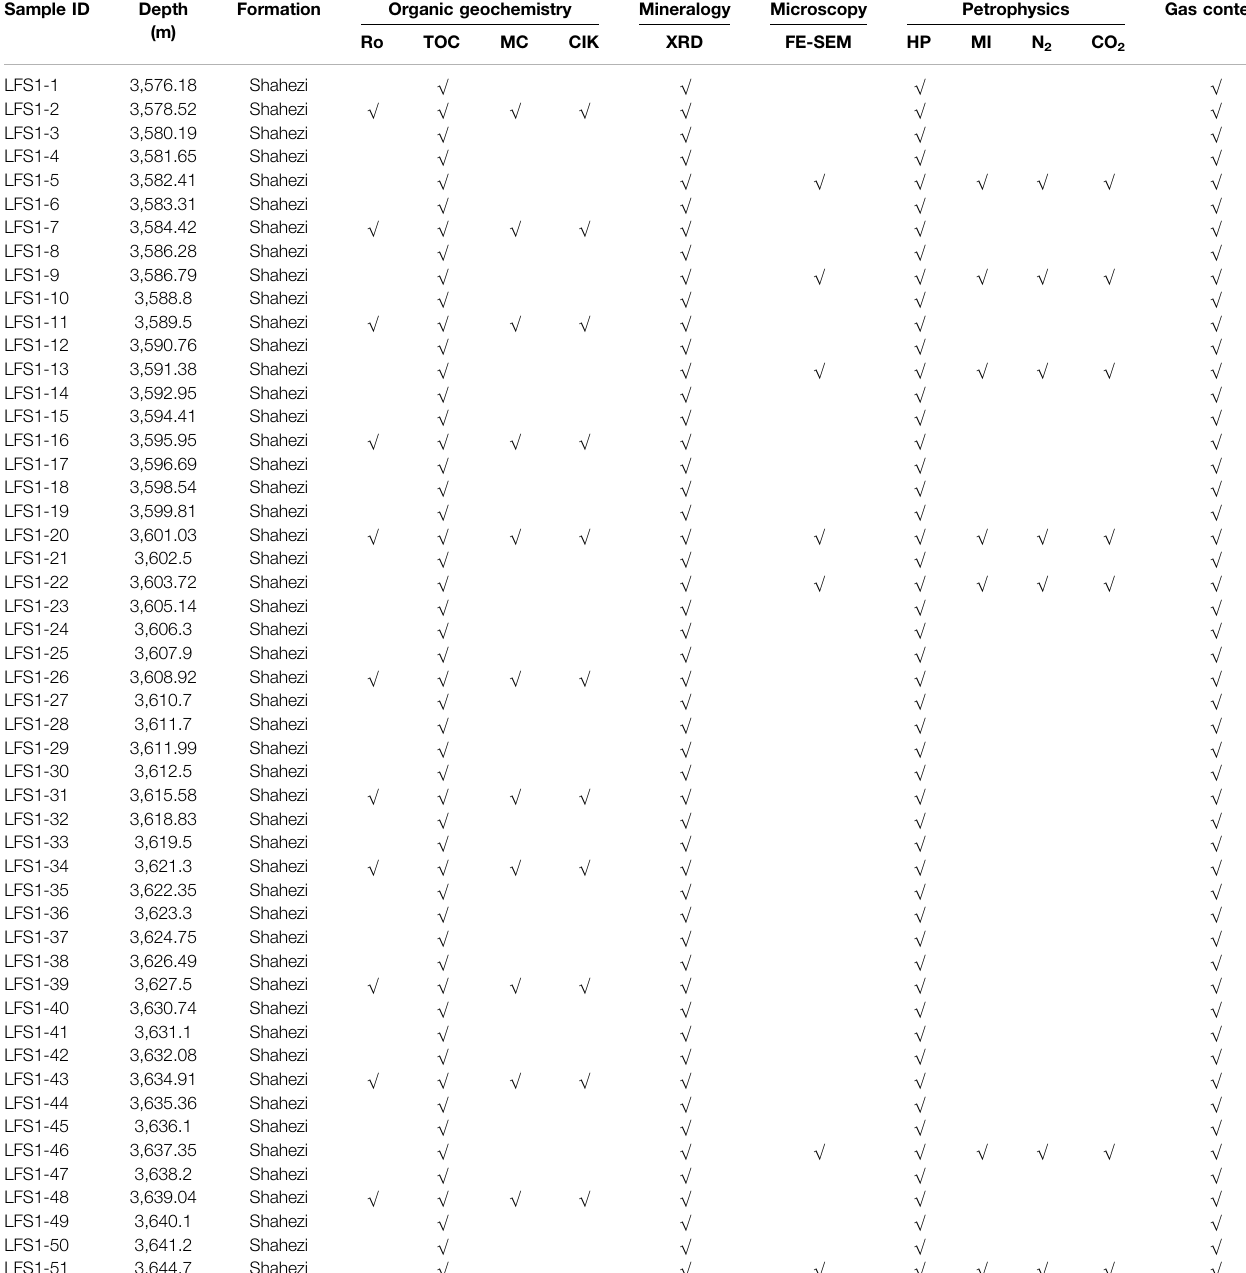
TABLE 1 | Measurements for 51 shale samples of the Shahezi Formation of the LFS1 well. Sample